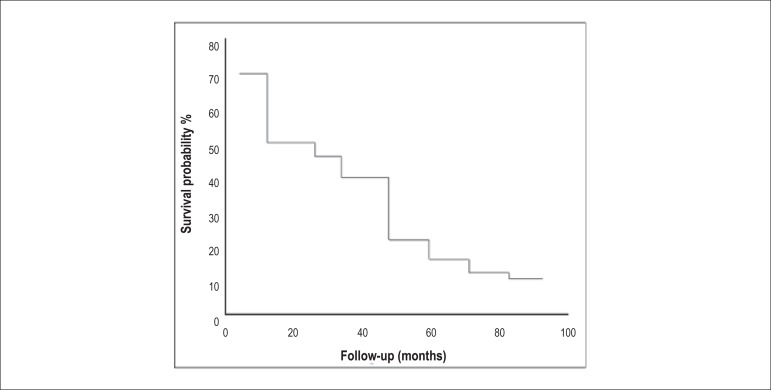
Cumulative overall survival curve.